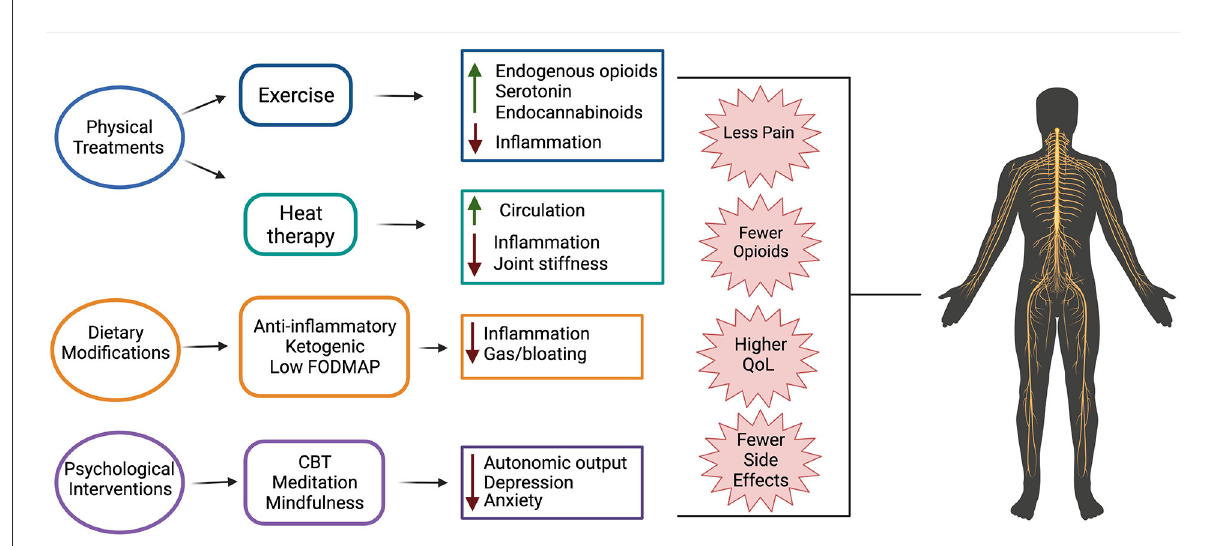
FIGURE1 Non-pharmacological therapeutics for treating SCI pain and their suggested mechanisms of action. Evidence suggests that physical treatments (exercise and heat therapy), dietary modifications (anti-inflammatory, ketogenic, and low FODMAP diets), and psychological interventions (cognitive behavioral therapy (CBT), meditation, and mindfulness) are beneficial for use in individuals with SCI-induced pain. Use of these treatments results in fewer side effects than traditional pharmacological treatments, less opioid use, reduced pain, and overall higher quality of